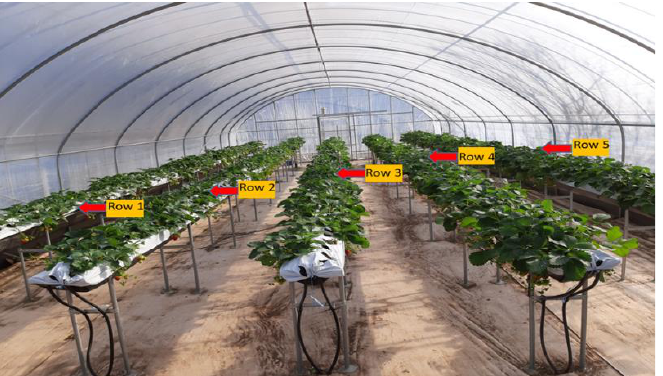
Figure 1. The strawberry experiment in the greenhouse under controlled environmental conditions.